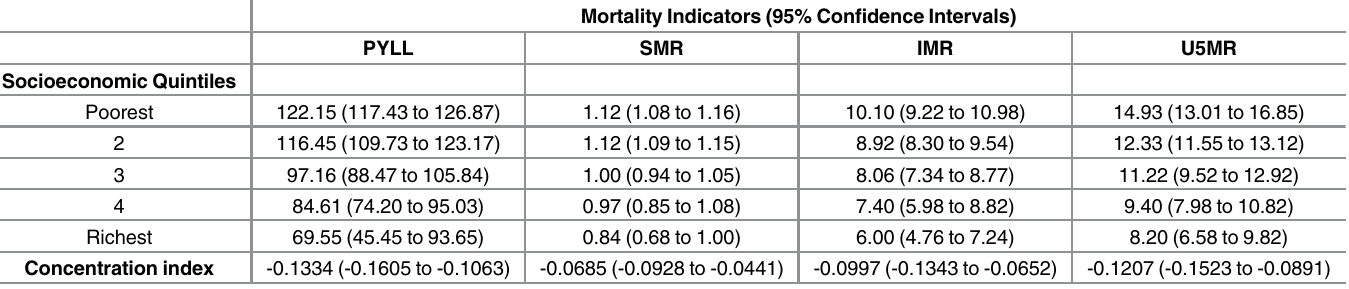
Table 3. Distribution of mortality indicators by socioeconomic